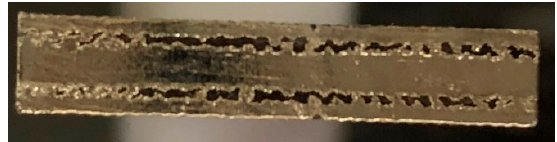
Figure 6. Electrical conductivity values of bio-composites: ( a ) CF-Rosin; ( b ) CF-Flax / Epoxy.